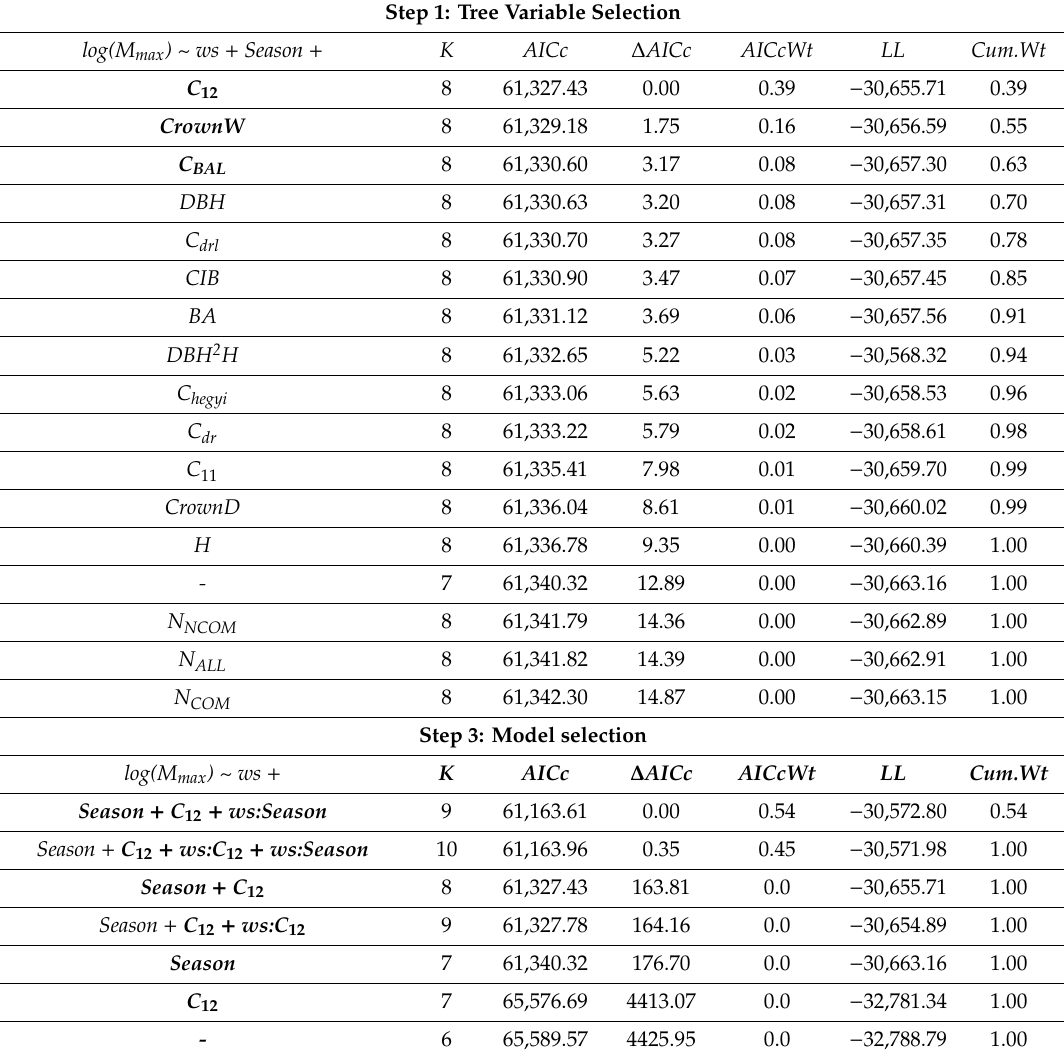
Table 3. Season model selection. Step 1: Tree Variable